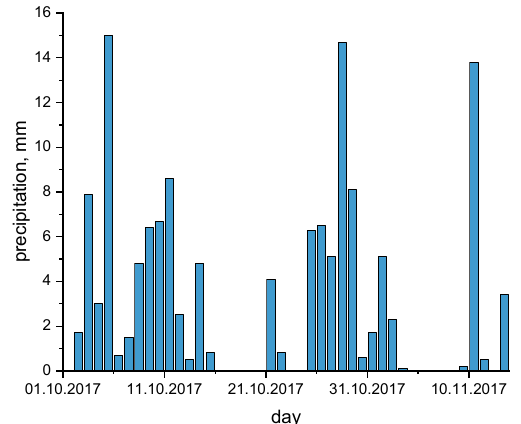
D Figure 5. Weather charts respectively (W—High pressure area, N—Low pressure area): ( A ) 1 X, ( B ) 12 X, ( C ) 23 X, ( D ) 3 XI. The analyzed period was relatively rainy (Figure 6). The occurred rainfall was moderately intensive, with intensities between 0.1–2.5 mm per 10 min, which is a characteristic domain of the Polish climate in October and November. During 40 analyzed days, there were 32 rainy days, with 3 days as a dust of precipitation which means h d = 0.01 mm. The daily rainfall totals ranged from 0.1 mm to 14.7 mm, and the 40 days total was only 134.8 mm. Consecutive 10-day totals were 56.3, 12.7, 43.8 mm and 21.5 mm, respectively. In the analyzed period, the average air temperature was 7.1 °C,